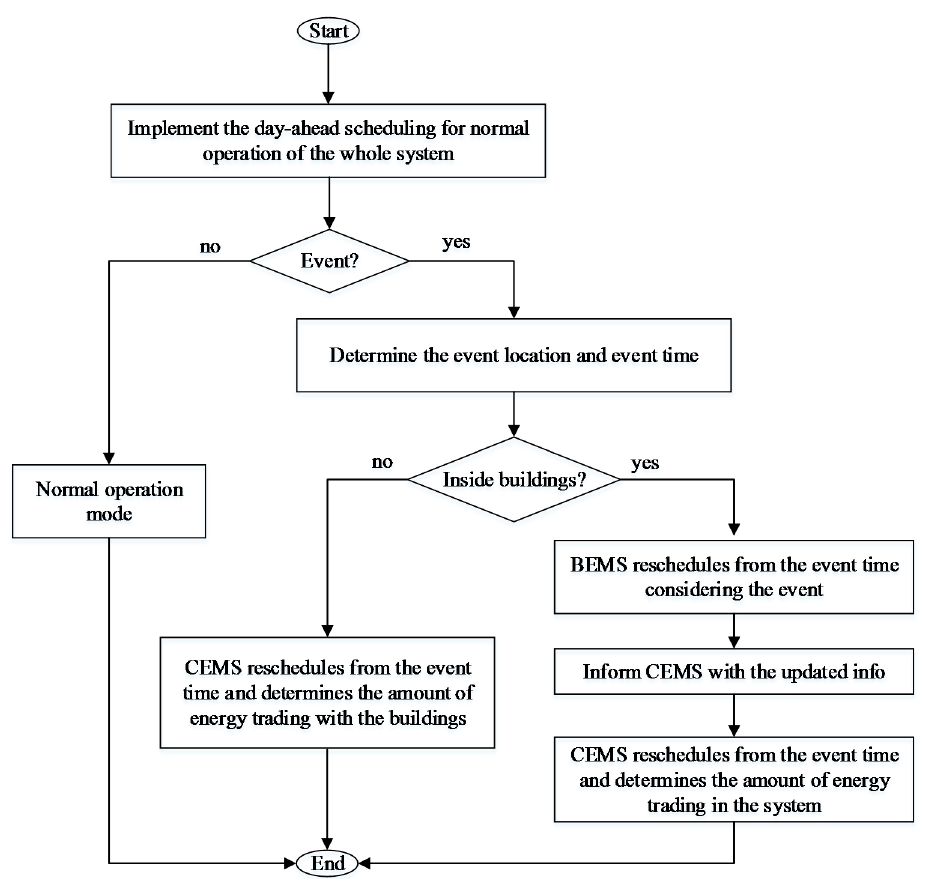
Figure 3. Operation strategy of the CCHP system in event time.